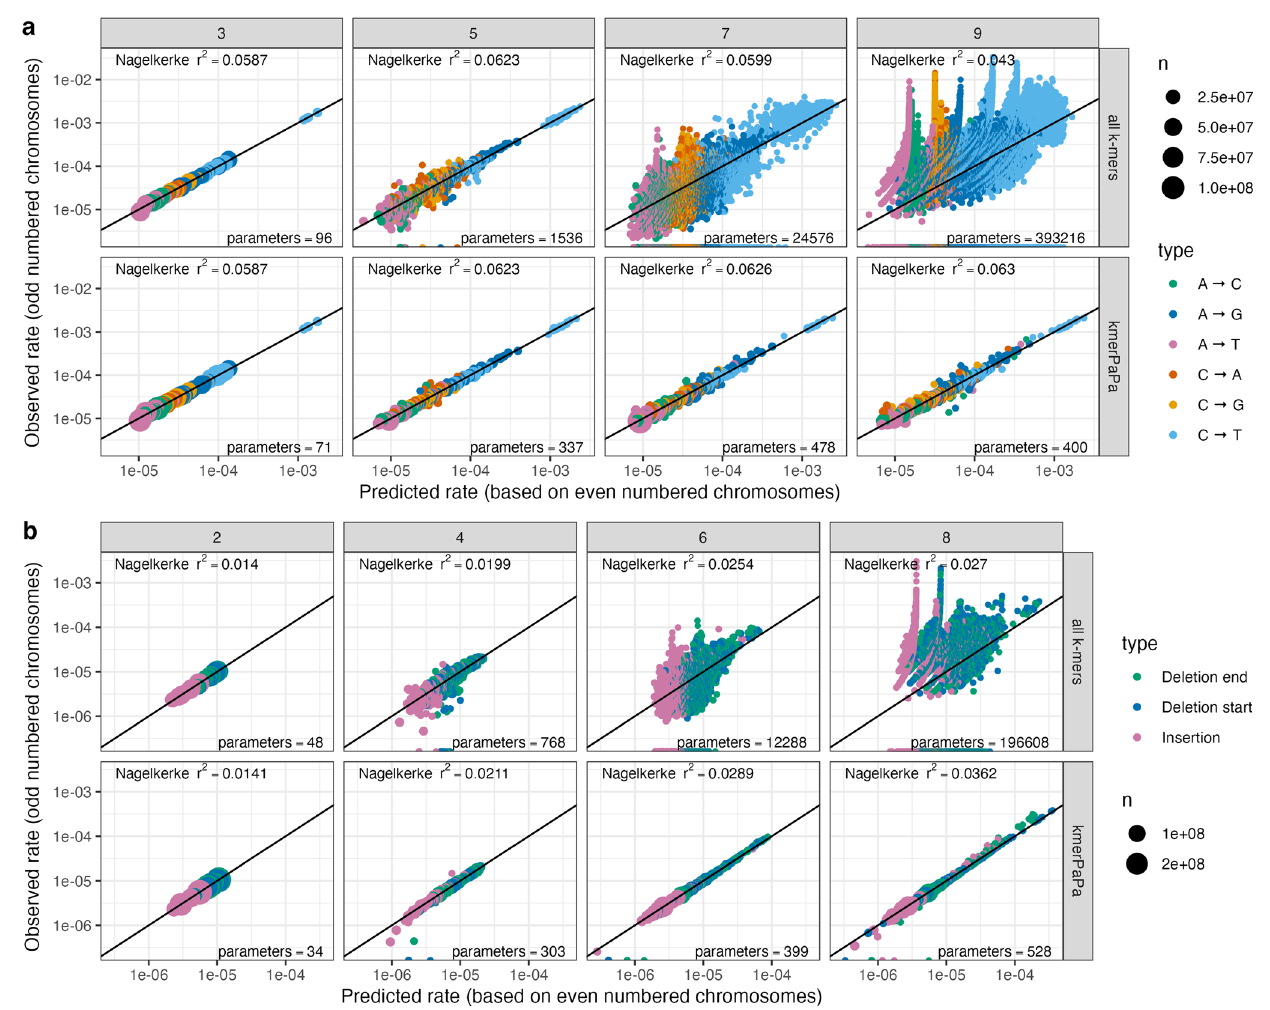
Fig. 2 | kmerPaPa performance on test data compared to predicting a rate per k-mer. All plots show predicted rates on training data (even-numbered chromo- somes) on the x axis and observed rates on test data (odd-numbered chromo- somes) on y axis. The fi rst row ( “ all k-mers ” ) shows the rates for each k-mer.